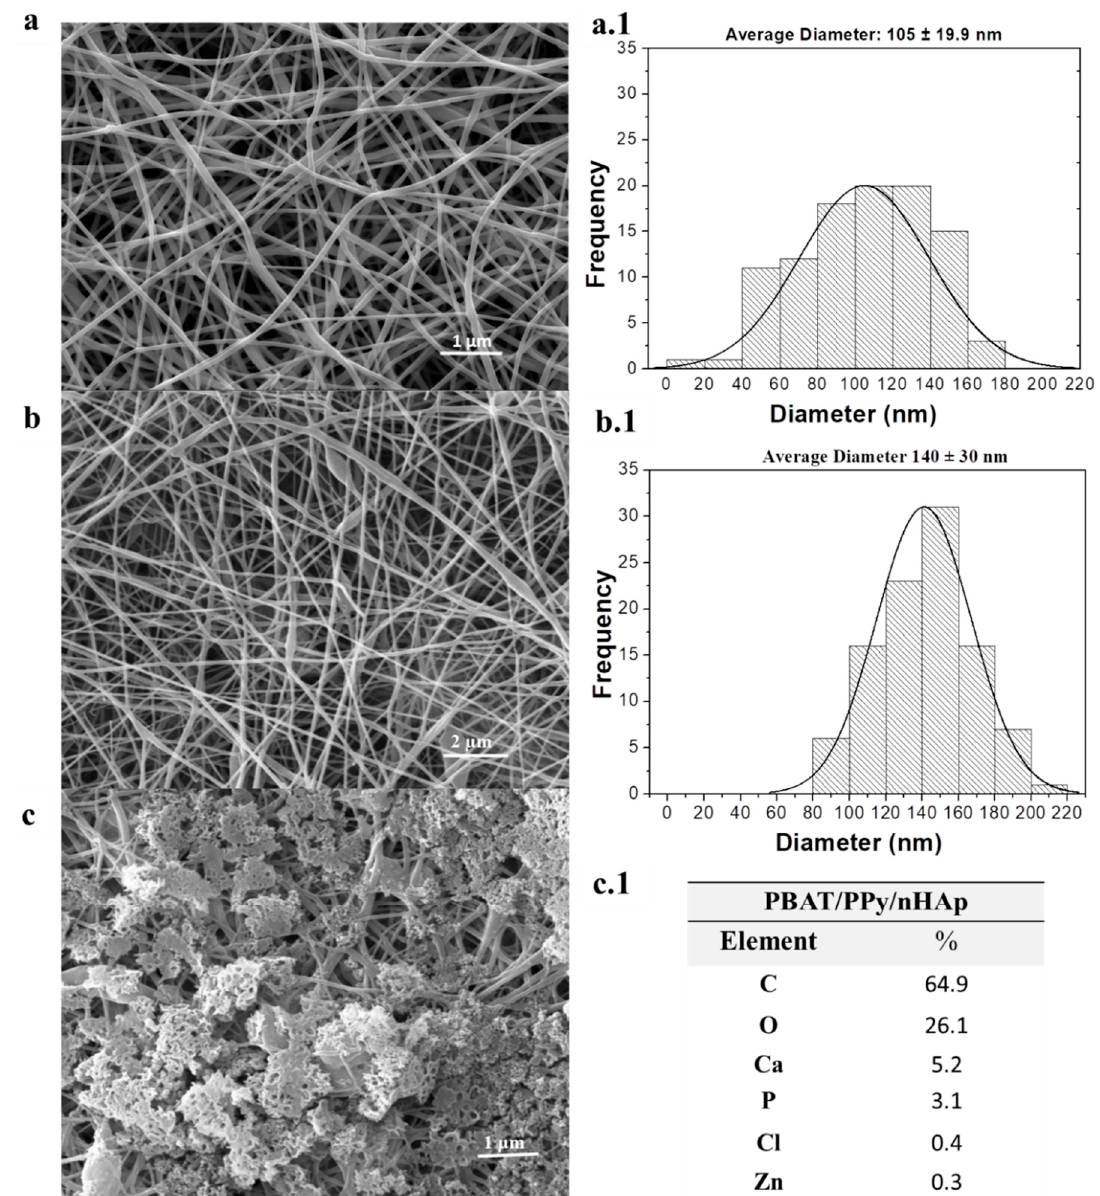
Figure 1. The figure shows SEM micrographs of the scaffolds: ( a ) PBAT, ( b ) PBAT/PPy, ( c ) PBAT/PPy/nHAp; mean diameter of the nanofibers for the PBAT and PBAT/PPy scaffolds as calculated by the Image J program were ( a.1 ) 105 ± 19.9 nm and ( b.1 ) 140 ± 30 nm, respectively; and the ( c.1 ) EDX of the PBAT/PPy/nHAp scaffolds showing its chemistry, presenting the Ca/P ratio of the stoichiometric HAp of 1.67.